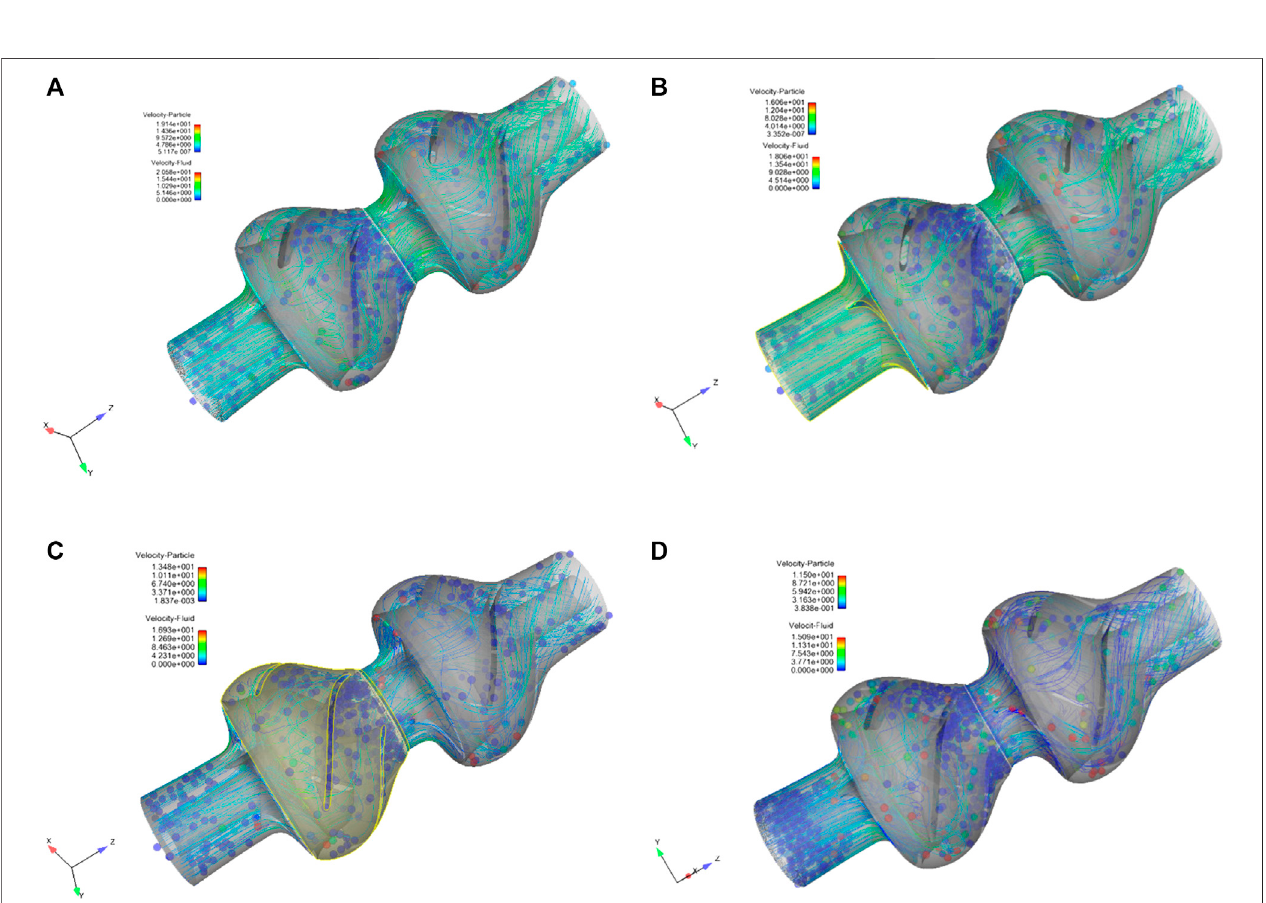
FIGURE 2 | Streamline and particle velocity diagrams of the two-stage deep-sea lifting pump: (A) 1,100 rpm, (B) 1,200 rpm, (C) 1,300 rpm, and (D) 1,450 rpm.